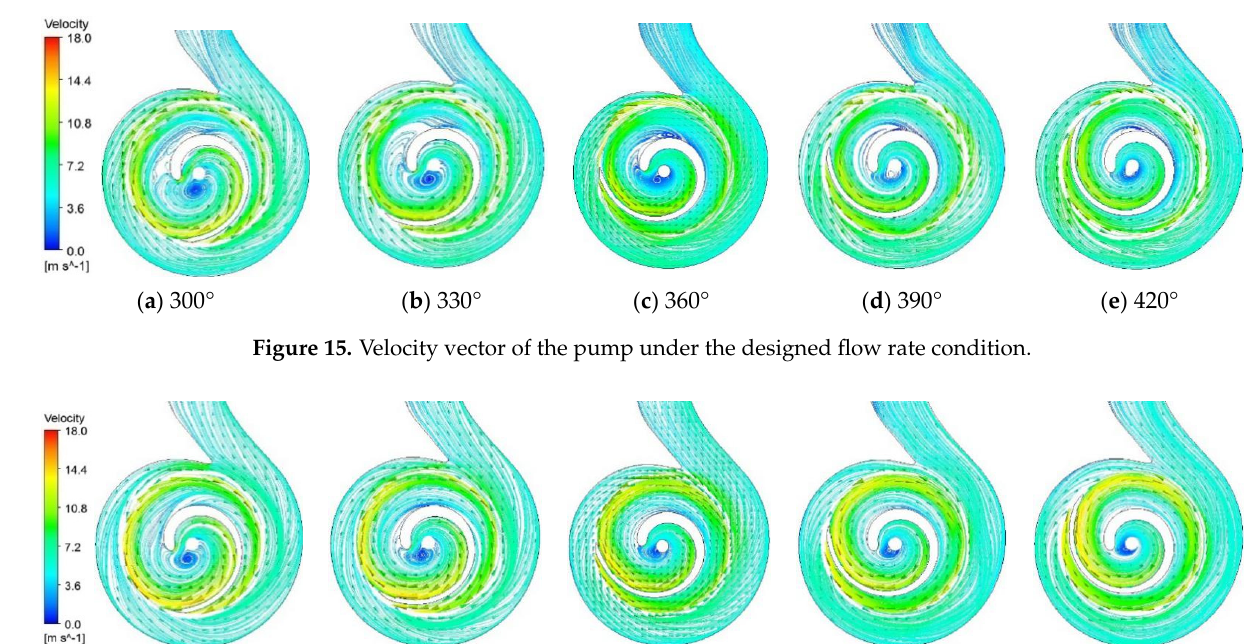
( e ) 420° Figure 14. Pressure distribution in the pump under part-loading conditions (0.6 Q d ). Figures 15–18 show the velocity vector and the pressure contour under the designed flow rate and larger flow rate conditions. Under these working conditions, the flow field in the pump is good, while for the impellers with 300° and 330° wrap angles, flow separation still happens. The pressure distribution in the circular direction is not axisymmetric, while the axisymmetric characteristic is improved when the wrap angle is increased. Comparing the performance of one impeller under different working conditions, it can be found that when the wrap angle is smaller than 360° the radial force